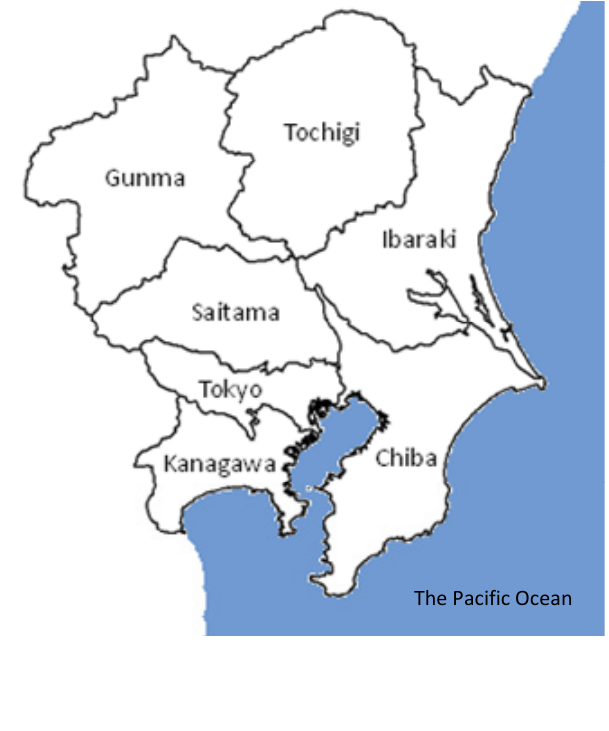
Figure 1. Map of the seven prefectures of the Kanto region of